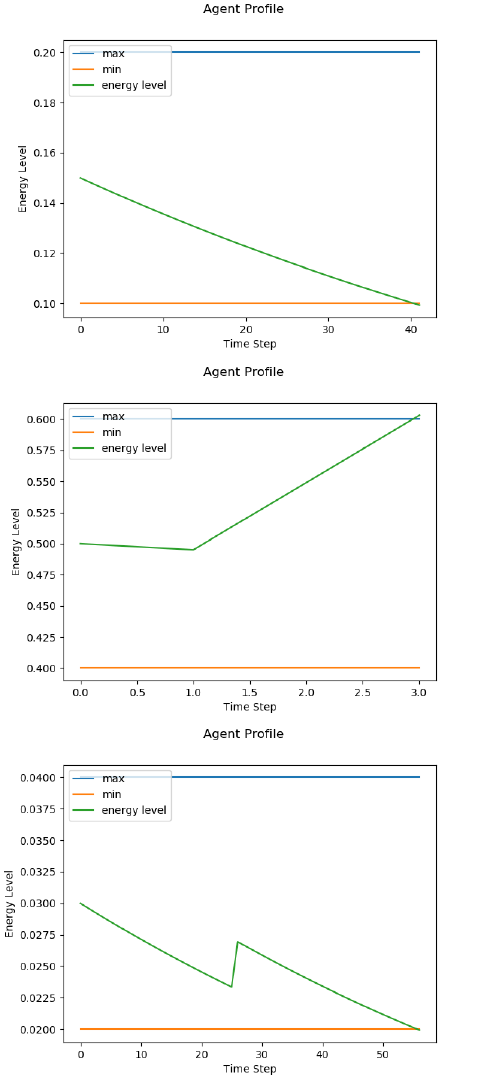
Figure 11. In these three graphs, the control of the A3CERG agent is shown over the current value of the internal variable (green line). It is observed that for different intervals of the variable, the behavior of this variable changes because the goal is to maximize the internal reward.